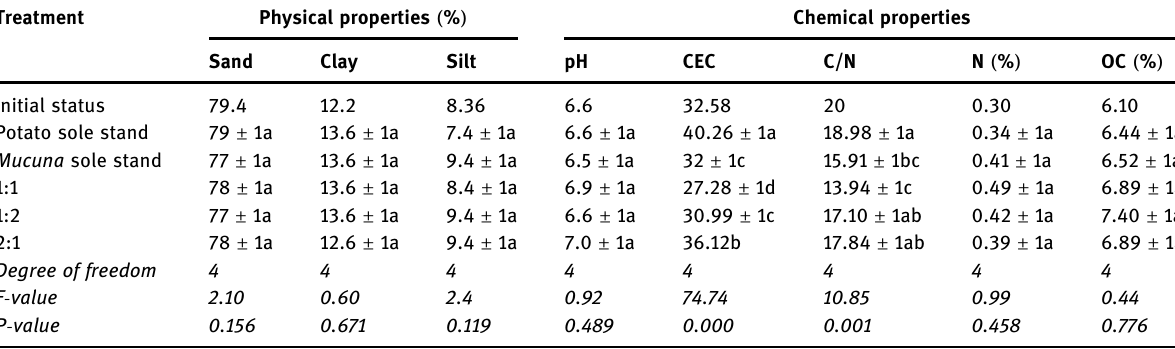
Table 6: Soil physicochemical properties before and after planting